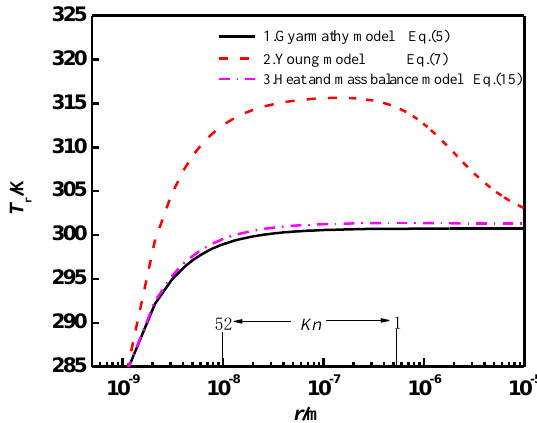
Figure 5. The relationship between the droplet temperature and the radius.